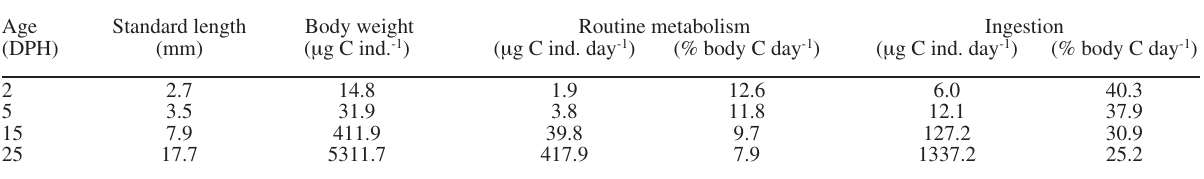
table 6. – Carbon budget for metabolism and ingestion of dusky grouper larvae based on estimated respiration rate at 20 o C.